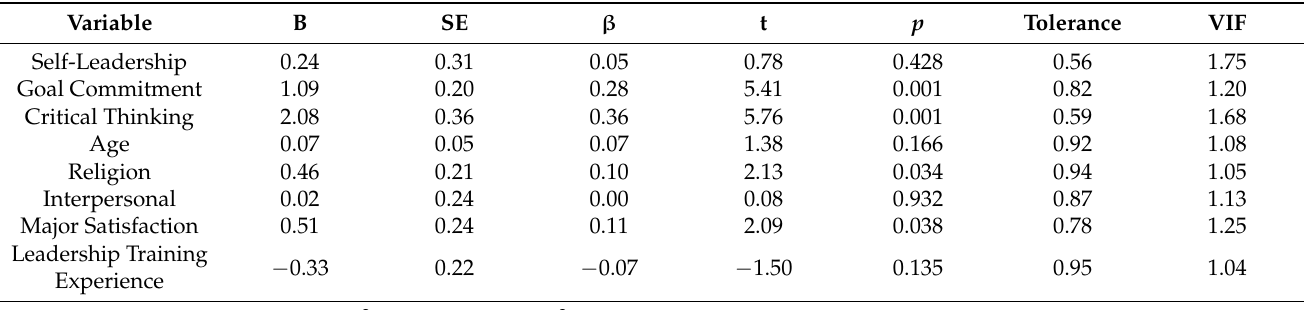
Table 4. The Influencing Factors on the Problem-Solving Abilities (N =